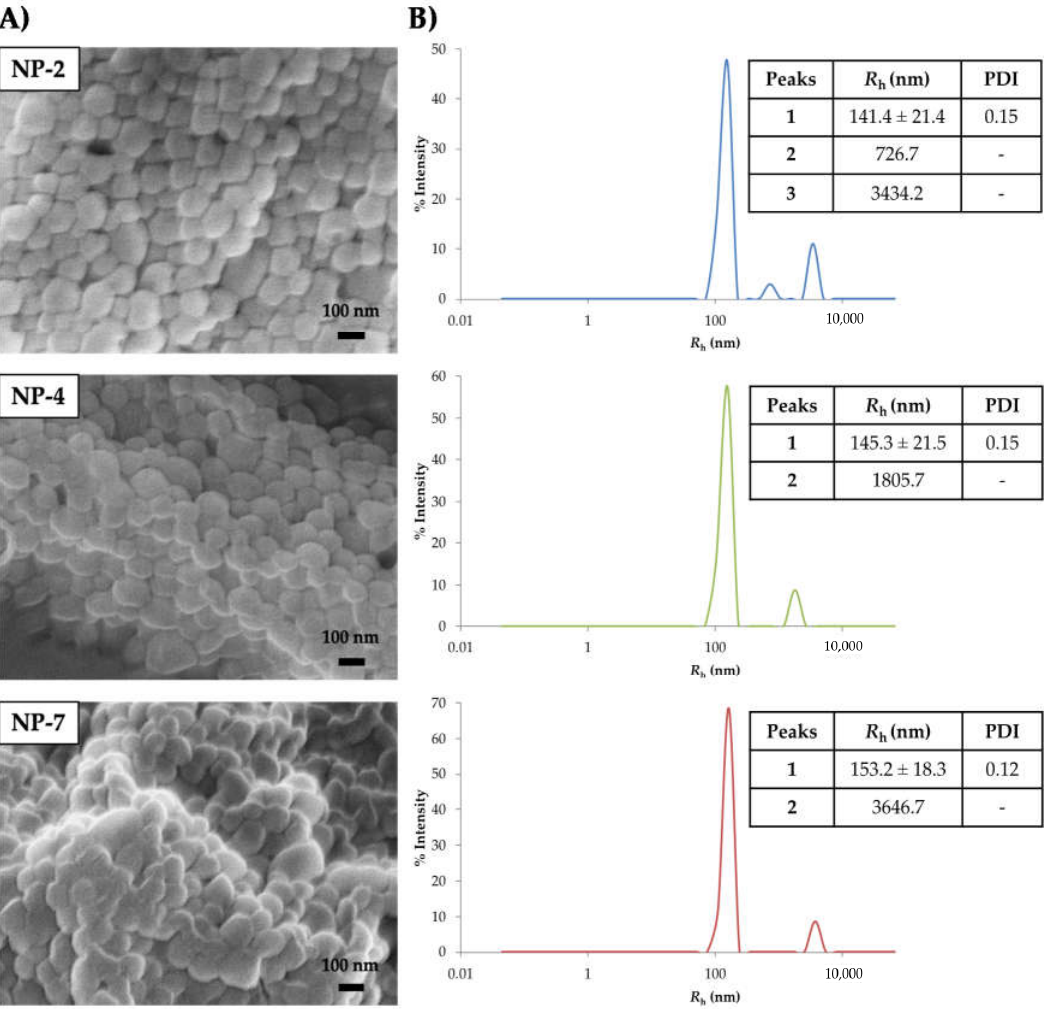
Figure 3. ( A ) Representative SEM (scanning electron microscopy) images of blank nanoparticles (NP-2) and PHA-loaded nanoparticles (NP-4, NP-7). ( B ) Representative size distribution of blank nanoparticles (NP-2) and PHA-loaded nanoparticles (NP-4, NP-7). Results are shown as the mean of 40 measures ± standard deviation (SD). PDI refers to polydispersity of NPs.